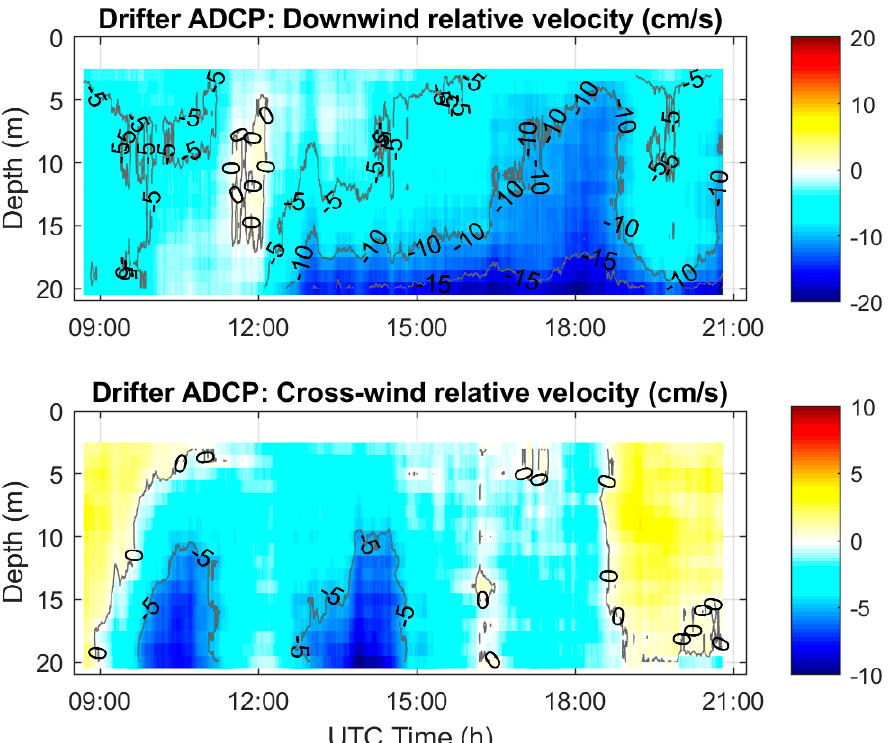
Figure 7. Color-coded contour diagrams of the relative currents measured by the CODE ADCP on 9 April 2019, projected in the down- ( top ) and cross- ( bottom ) wind directions. Positive is down-wind and to the right of the wind (looking downwind).